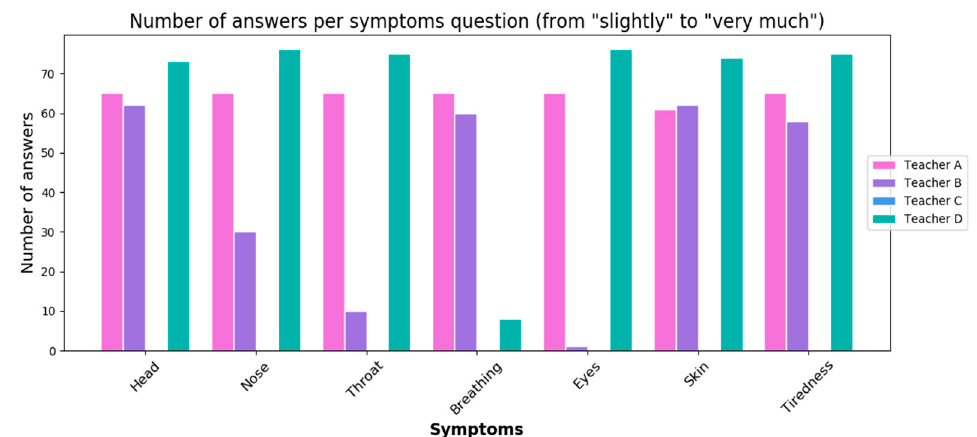
Figure 4. Number of reported symptoms per teacher during the